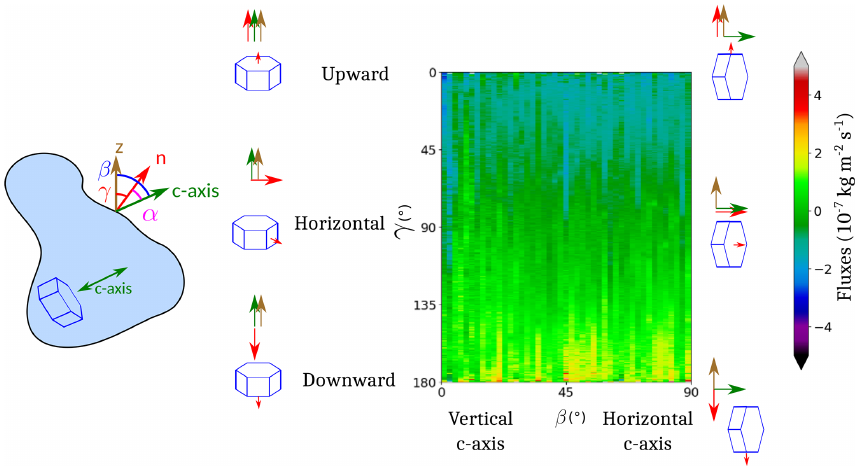
Figure 16. Interpretation of the diagram of mean flux against β = ( z , c ) and γ = ( z , n ) . The small red arrows represent the facets taken into